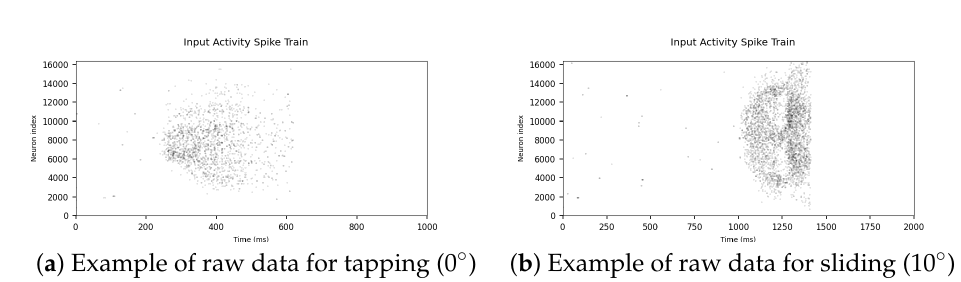
Figure 4. Spike raster plots of the NeuroTac output data for Tap ( a ) and Slide ( b ) at 10 ◦ .